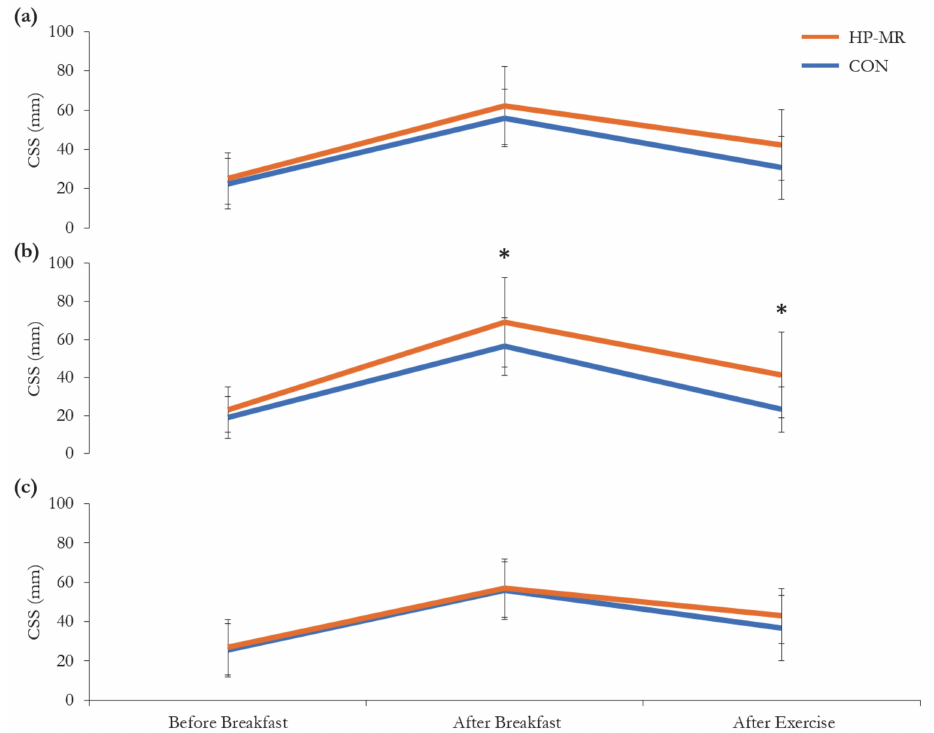
Figure 5. Composite satiety score during the HP-MR and CON interventions in ( a ) all participants ( n = 43), ( b ) females ( n = 19), and ( c ) males ( n = 24). Data are mean ± standard deviation. * Significant difference ( p < 0.03) between the HP-MR and CON diets, as assessed by a mixed analysis of variance. Abbreviations: CON: control, standard North American diet; CSS: composite satiety score; HP-MR: high-protein meal